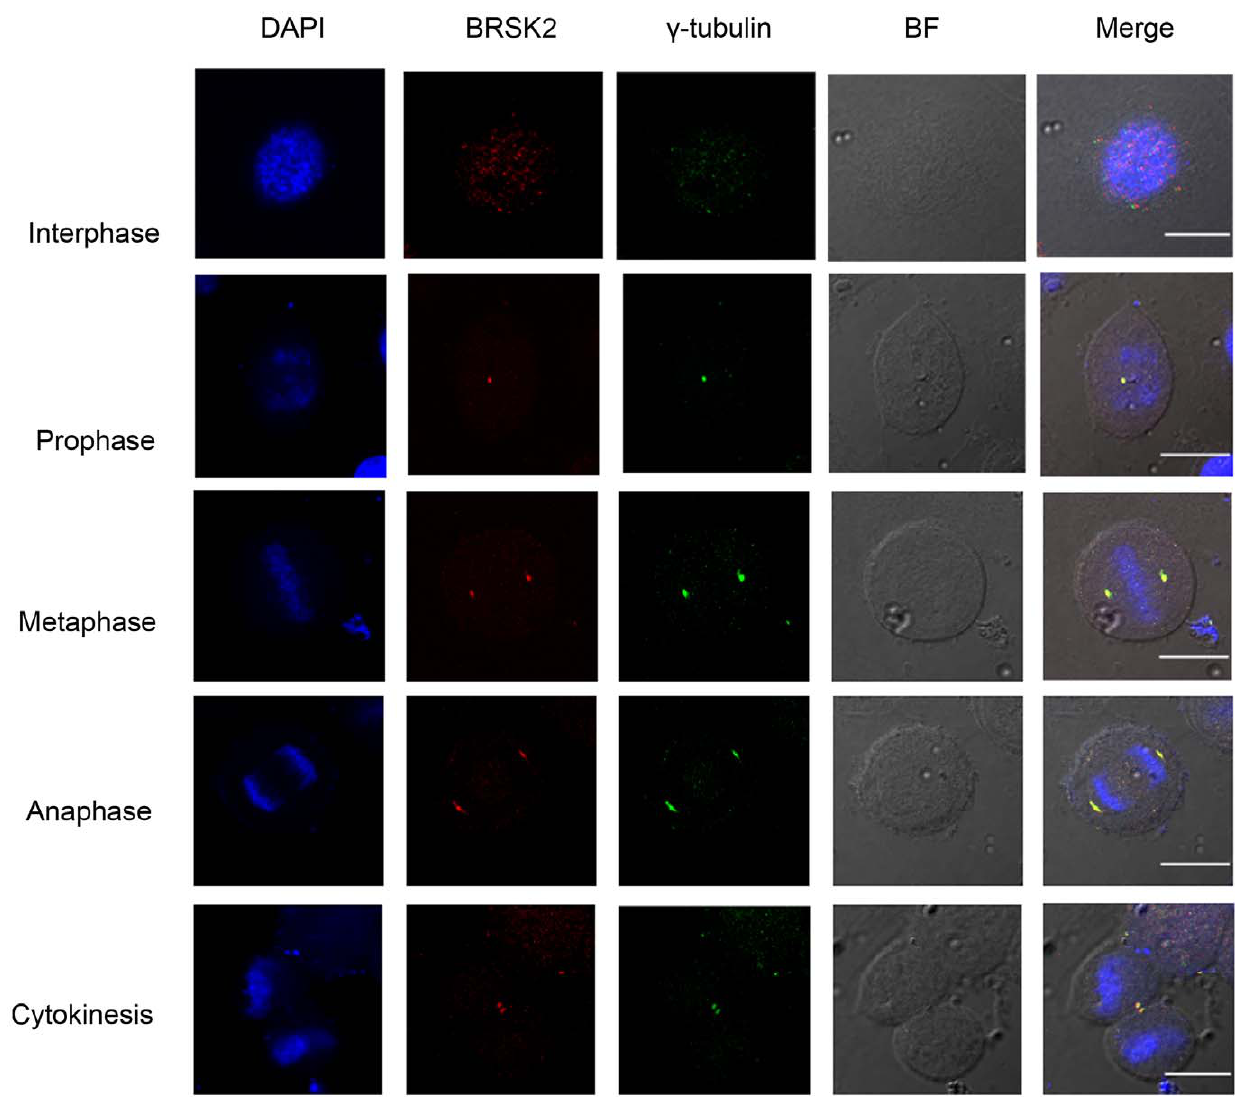
Figure 1. BRSK2 co-localizes with the centrosomes during mitosis. Synchronously growing HeLa cells were fixed and stained as described in ‘‘Materials and Methods’’. This figure shows representative images of dividing cells captured in different channels for BRSK2 (red), c -tubulin (green), and DAPI (blue). All images were captured with an Olympus FluoView FV1000 confocal fluorescence microscope and a 60x oil immersion objective lens. BF: bright field. Scale bar, 10 m